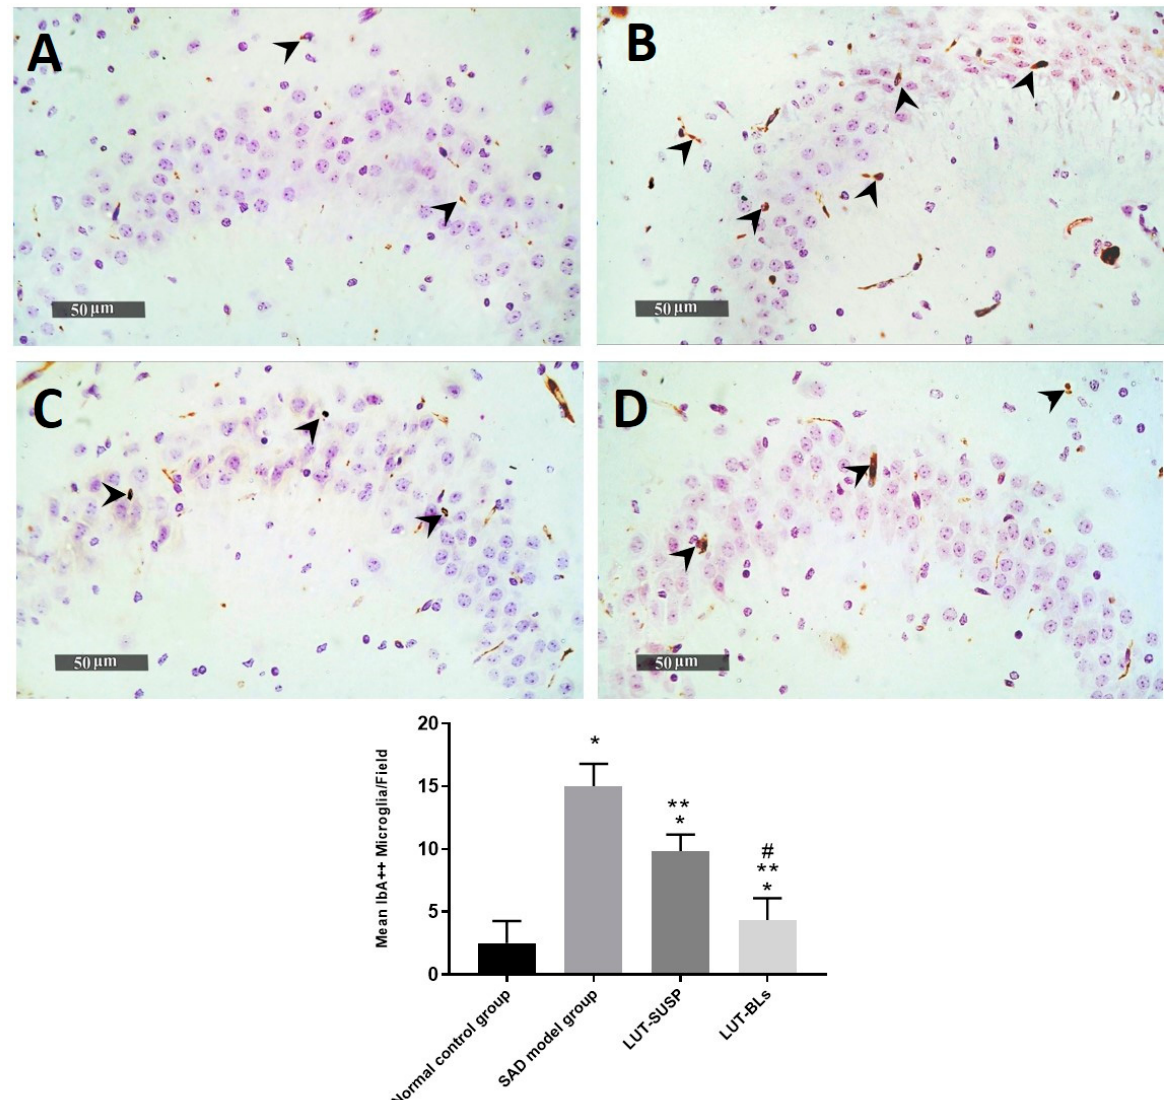
Figure 12. Hippocampal IbA-1/++ activated microglial cell count expressed as the mean number of IbA-1/++ cells per microscopic field. ( A ) normal controls, ( B ) AD model samples, ( C ) LUT suspension samples, and ( D ) LUT-BL samples. Data are expressed as means ± SD. * Statistically significant difference from normal control group, ** statistically significant difference from the SAD model group, and # statistically significant difference from LUT suspension group.